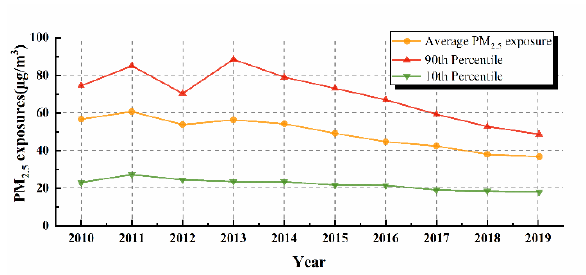
Figure 3. Changes in PM 2.5 exposures from 2010 to 2019